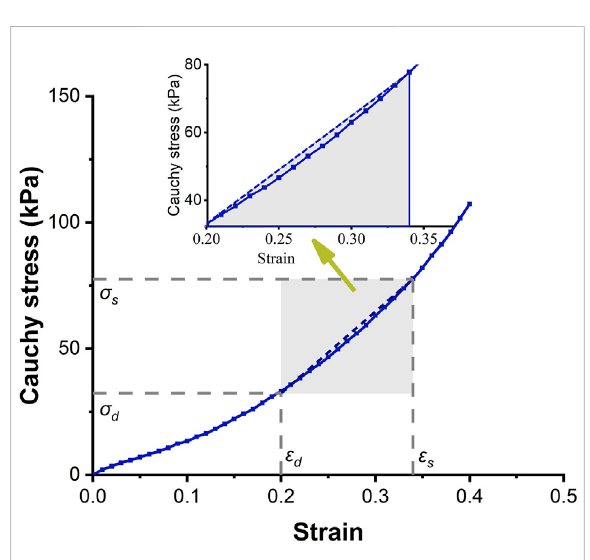
FIGURE 2 Circumferential stress-strain curve of the ascending aorta. The solid-dotted line represents the nonlinear stress-strain curve, and the dashed line represents a linear